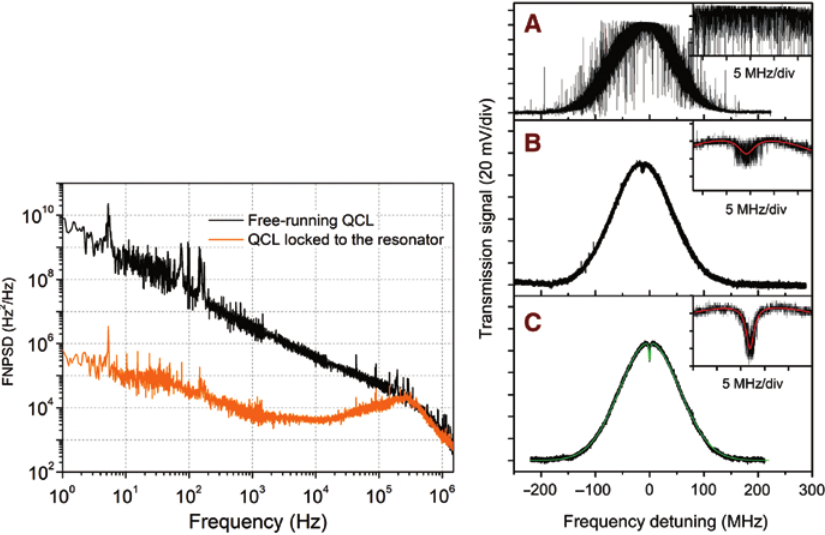
Figure 12: QCL FNPSDs (free-running and locked) and WGMR-assisted spectroscopy. Left: Frequency-noise power spectral density for a free-running (black trace) and locked (orange trace) QCL. The frequency cut-off around 300 kHz is due to the limited bandwidth of the detector. Reprinted with permission from [49], copyright 2016. Right: The whispering Gallery mode resonator of [49] is used to assist sub-Doppler spectroscopy of CO with a pump-probe scheme [50]. The three cases corresponding to 2 the different traces are free-running laser operated with the commercial driver (A); laser operated with the home-made driver in free-running (B) and locking (C) conditions. All three graphs have the same horizontal scale, representing the detuning from the center frequency of the transition. In each inset, a zoom of the top line profile is shown, over the same horizontal and vertical scales, with the red curves showing the Lorentzian fit of the dip (B, C). The thin green trace superimposed on the data in (C) is a simulation of the sub-Doppler feature based on the HITRAN data. Reprinted with permission from [50], copyright